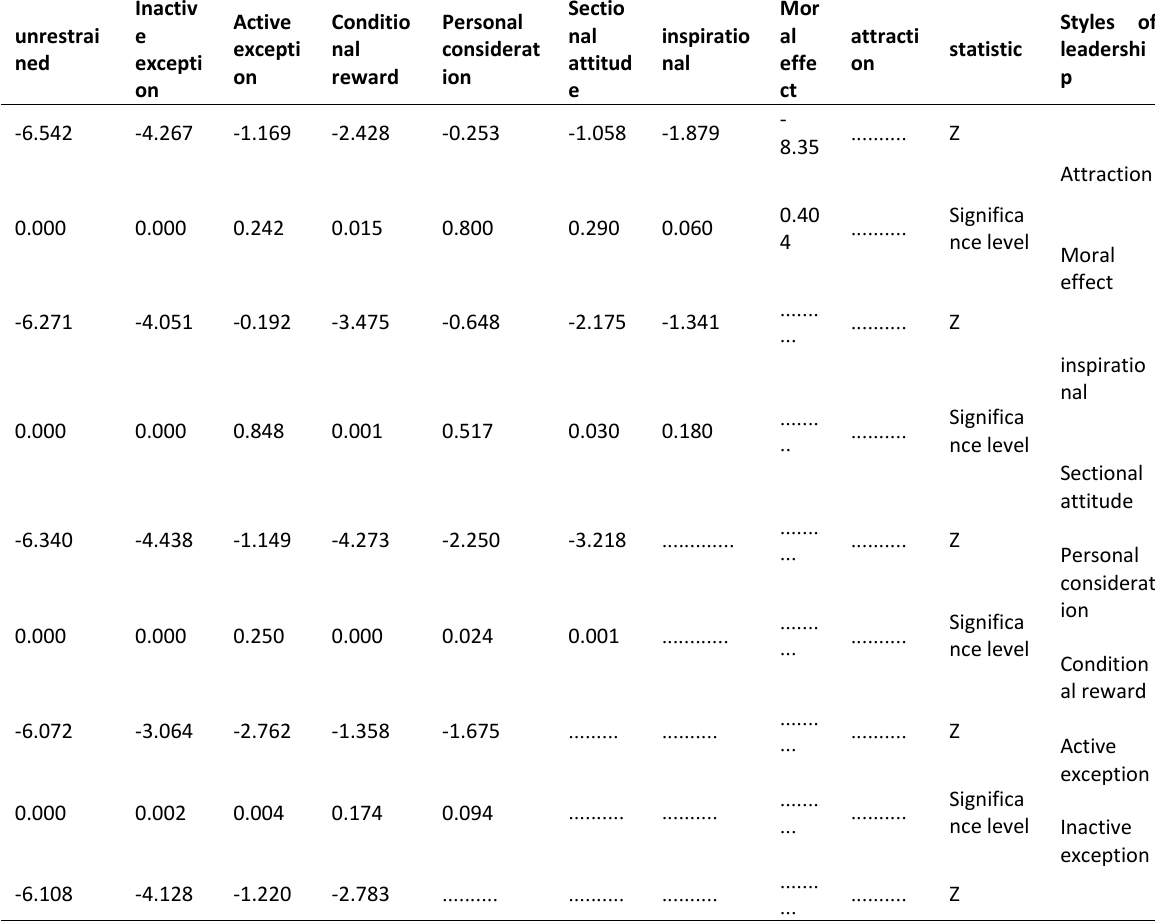
Table 7. Wilcoxon test results, difference between different styles of coaches’